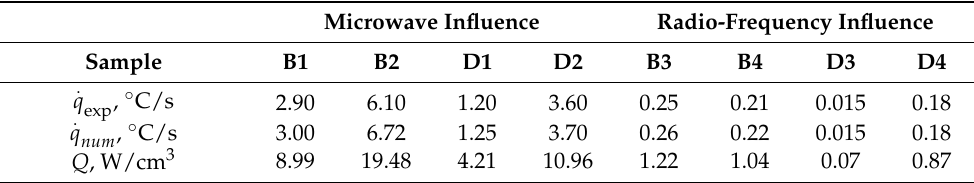
samples Q arising under the electromagnetic